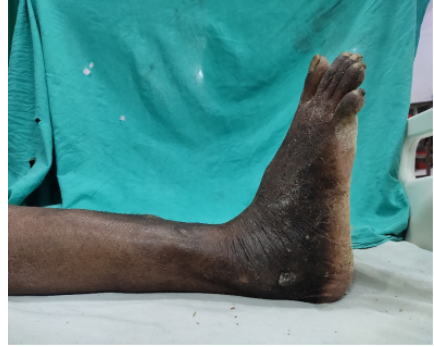
Figure 10. DORSIFLEXION AT ANKLE AFTER 6 MONTH